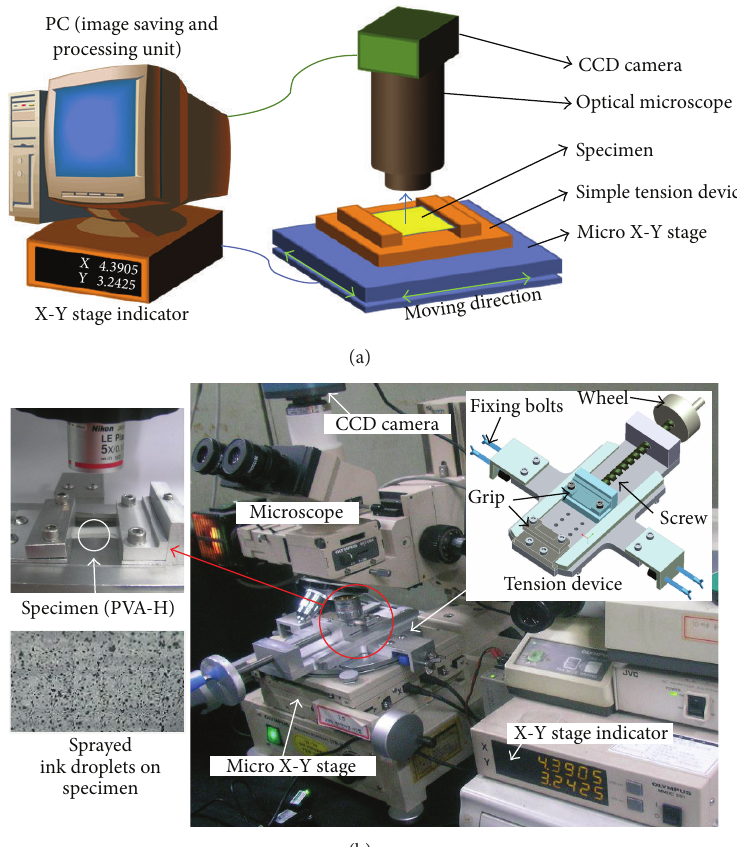
Figure 1: Experimental apparatus—(a) schematic of a PVA-H loading and deformation measurement device and (b) experimental